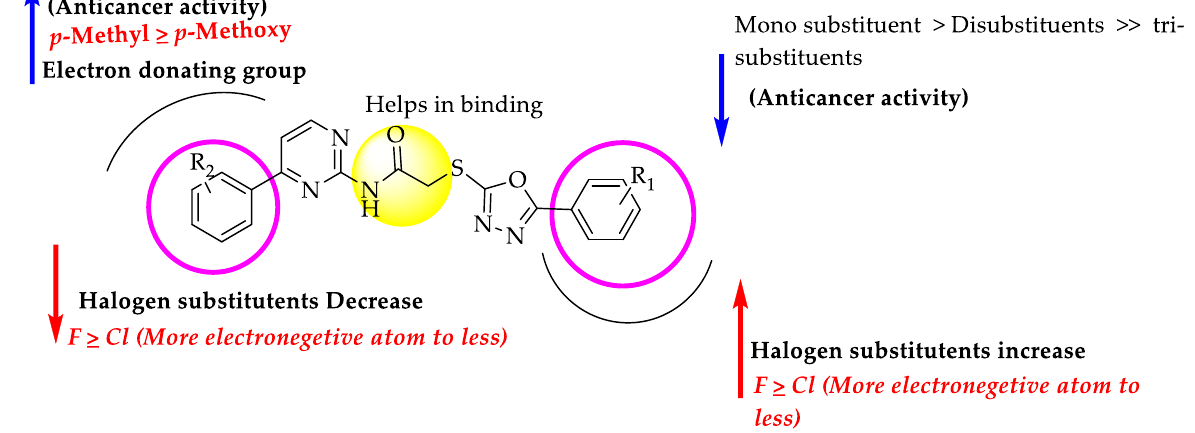
Figure 23. The structure-activity relationship of pyrimidine-1,3,4-oxadiazole